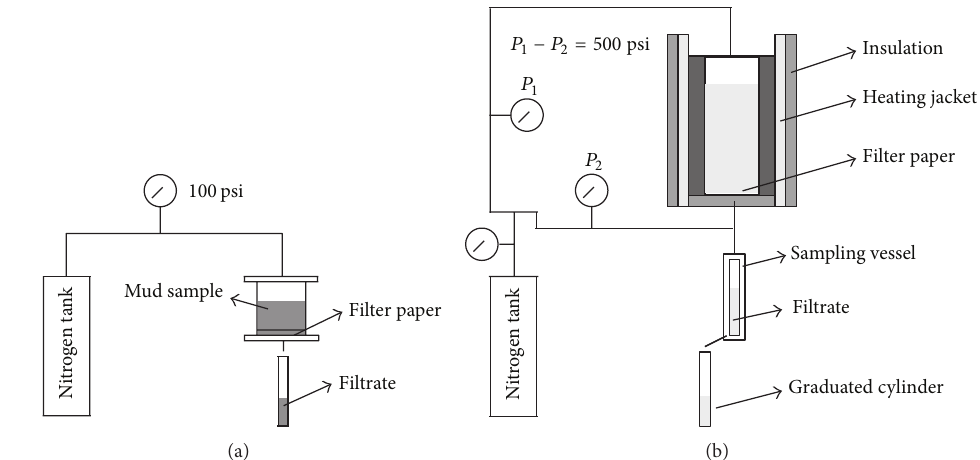
Figure 3: Schematic of the API (a) and HTHP (b) filtration test apparatus.